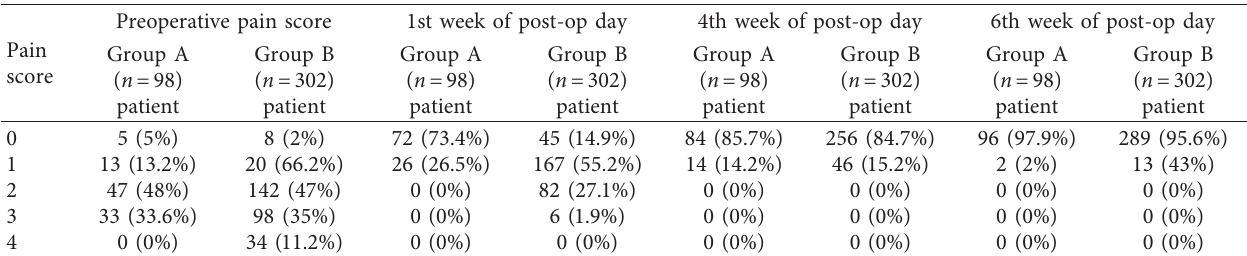
Table 4: Comparison of preoperative and postoperative pain score in group A and group B patients (% within group).